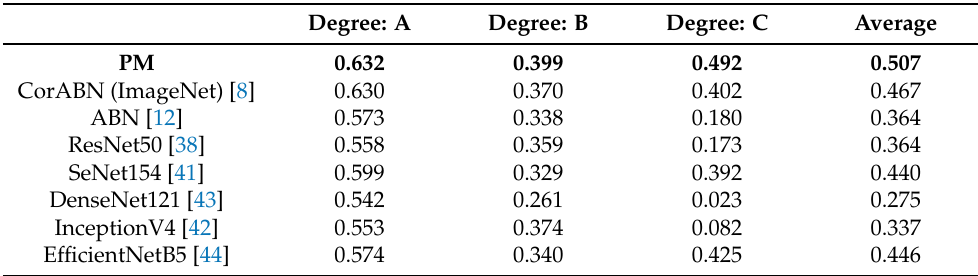
Table 9. F1-scores of PM and CMs in the distress type of concrete scaling. The best scores for each degree and the average are depicted in bold.